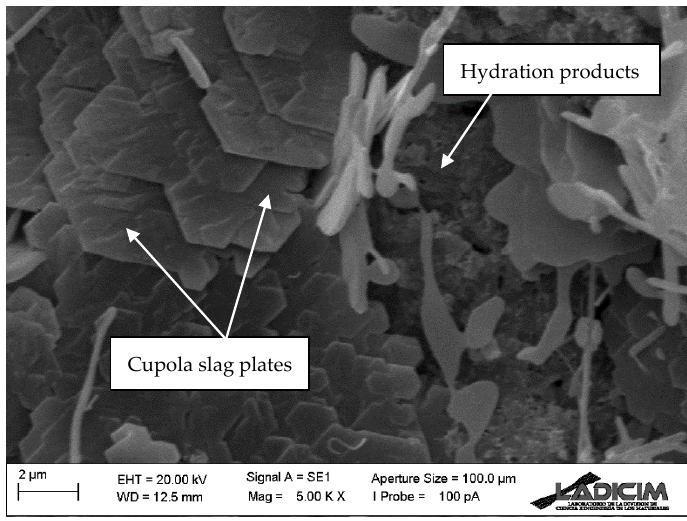
Figure 6. Appearance of the cupola slag after reacting on the cement paste (5000 × ).